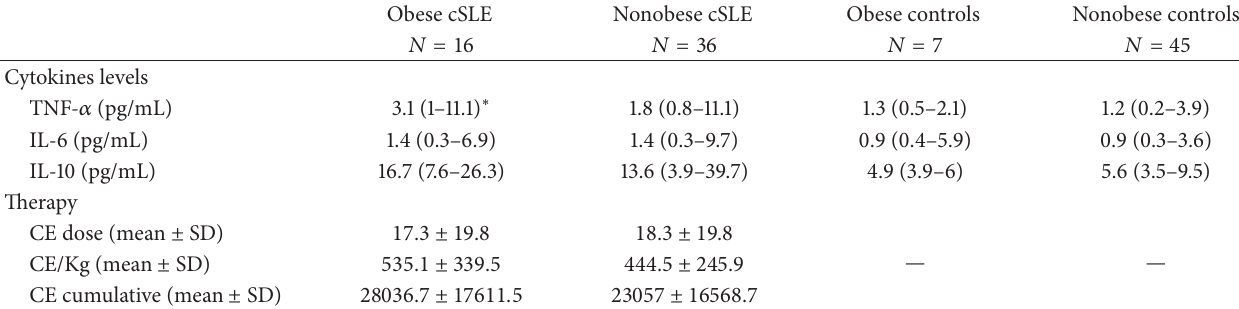
Table 3: Cytokines levels and therapy information from subjects subdivided into obese and